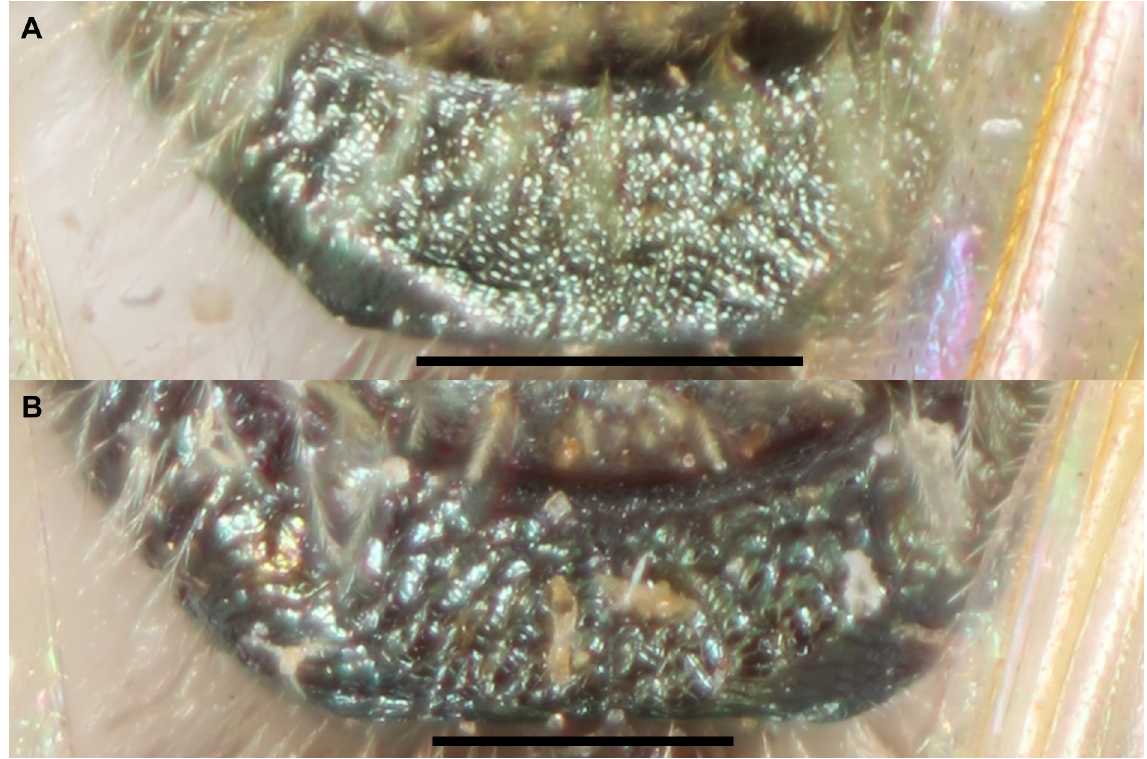
Fig. 88. Metapostnotum. A . Lasioglossum pseudotegulare (Cockerell, 1896), ♀, completely dull with fine rugae obscured by microsculpture. B . L. tegulariforme (Crawford, 1907), ♀, shiny with strong rugae. Scale bars = 0.25